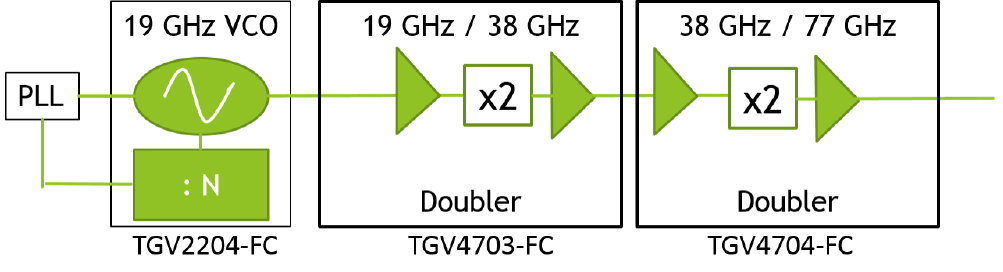
Figure 2. Schematic of the flip chip based source.